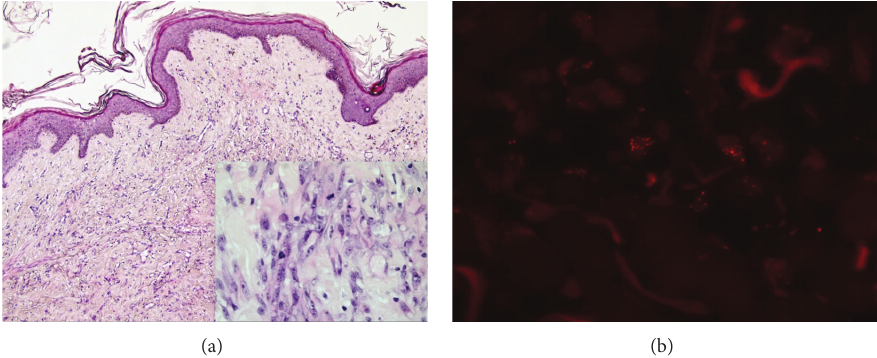
Figure 1: Reexcision of postradiation AVL of the breast skin one month after initial biopsy. Capillary vessels were lined by inconspicuous endothelialcellsandrandomlyarrangedthroughoutthedermis((a);H&E, × 10).Attheperipheryofthelesion,asmallfocusdisplayedvascular structures with frank cytological atypia and mitotic figures, consistent with well-differentiated post-RT cutaneous BA ( inset ; H&E, × 40). MYC amplification at FISH analysis strongly supported the diagnosis of AS versus AVL (b). In order to detect copy number abnormalities of MYC oncogene (located at 8q24,12-q24.13), the LSI C-MYC SpectrumOrange Probe (Abbott Molecular Inc., Abbott Park, IL, USA) was used. The fluorescent signals were evaluated under an epifluorescence microscope (DMRD, Leica Mikrosystems Vertrieb GmbH, Germany), using a HBO 100 W mercury arc lamp and the appropriate single band filters (orange and blue) for the two fluorescence signals.